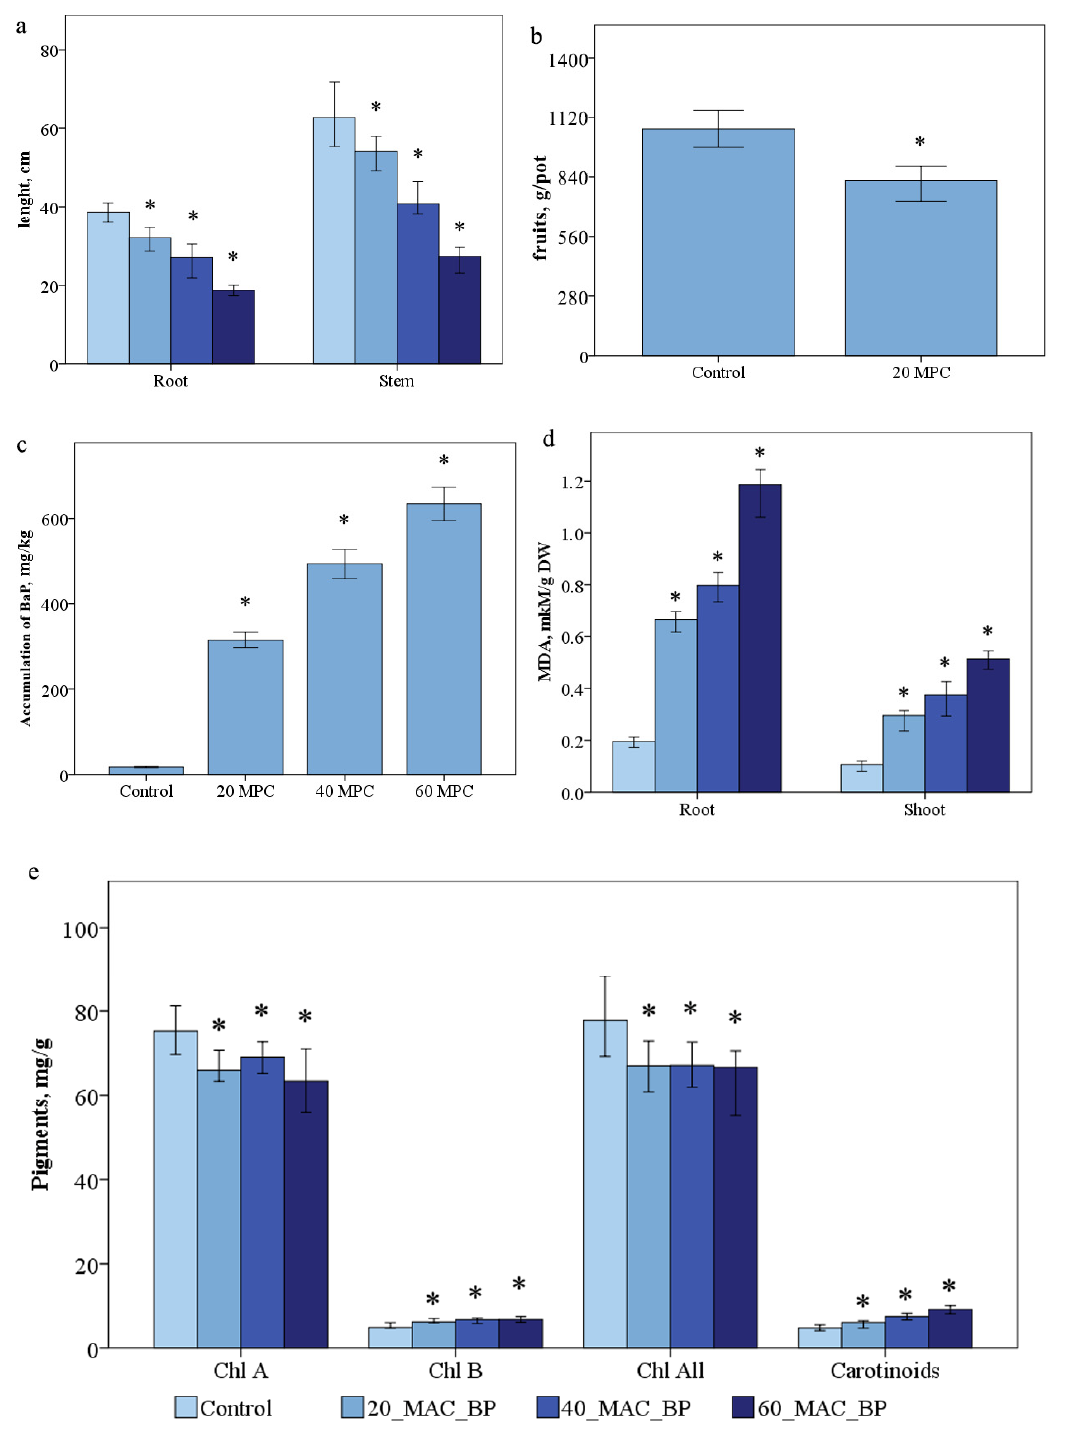
Figure 1. Effect of BaP on ( a ) accumulation, ( b , c ) morphobiometric parameters of plants, ( d ) MDA, ( e ) pigments in Solanum lycopersicum plants. Statistically significant differences ( p ≤ 0.05) comparing the treated plants to the control plants are marked with an asterix (*).